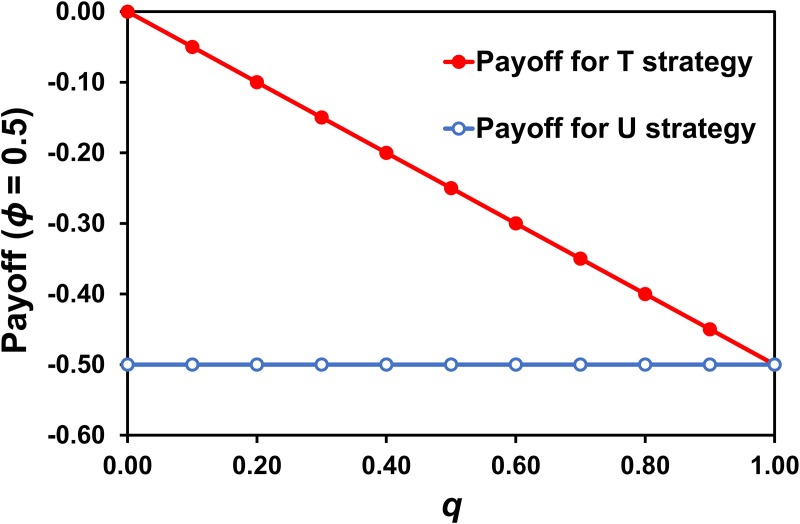
Payoff functions.Payoffs from T (treat with antibiotics) and U (do not treat with antibiotics) for a representative probability of bacterial infection of ϕ = .5, showing T as a dominant strategy. For different values of ϕ > 0, only the slope of the function changes. The values used to generate the graph are given in S1 Table.